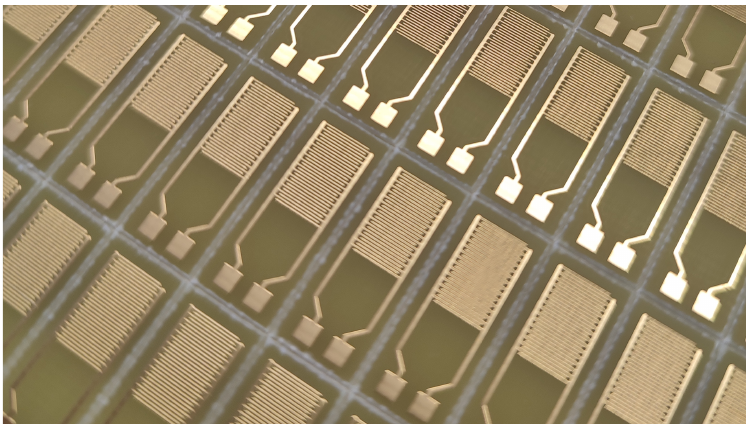
Figure 1. Sheet of interdigitated electrodes with a width and spacing of 130 µ